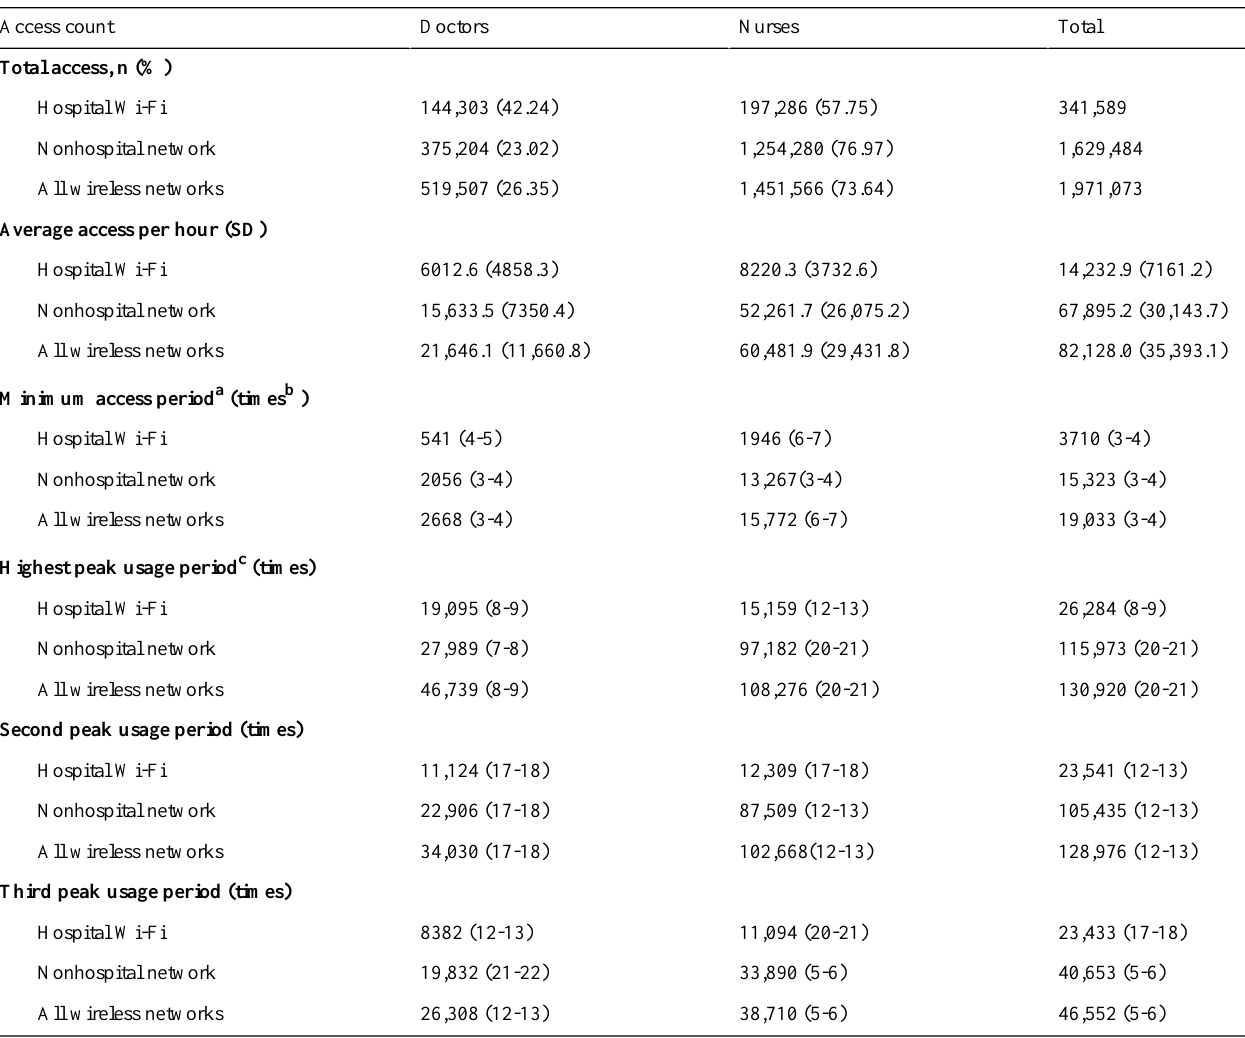
Table 1. Comparison of hourly wireless network access to the mobile Asan Medical Information System in according to user